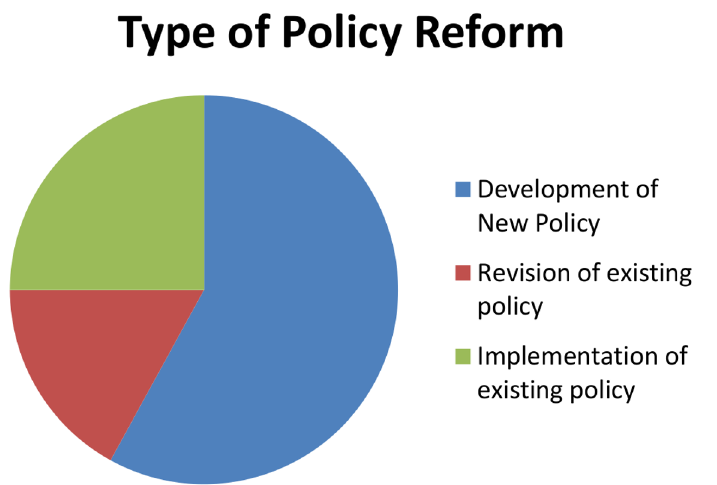
Fig 1. Type of Policy